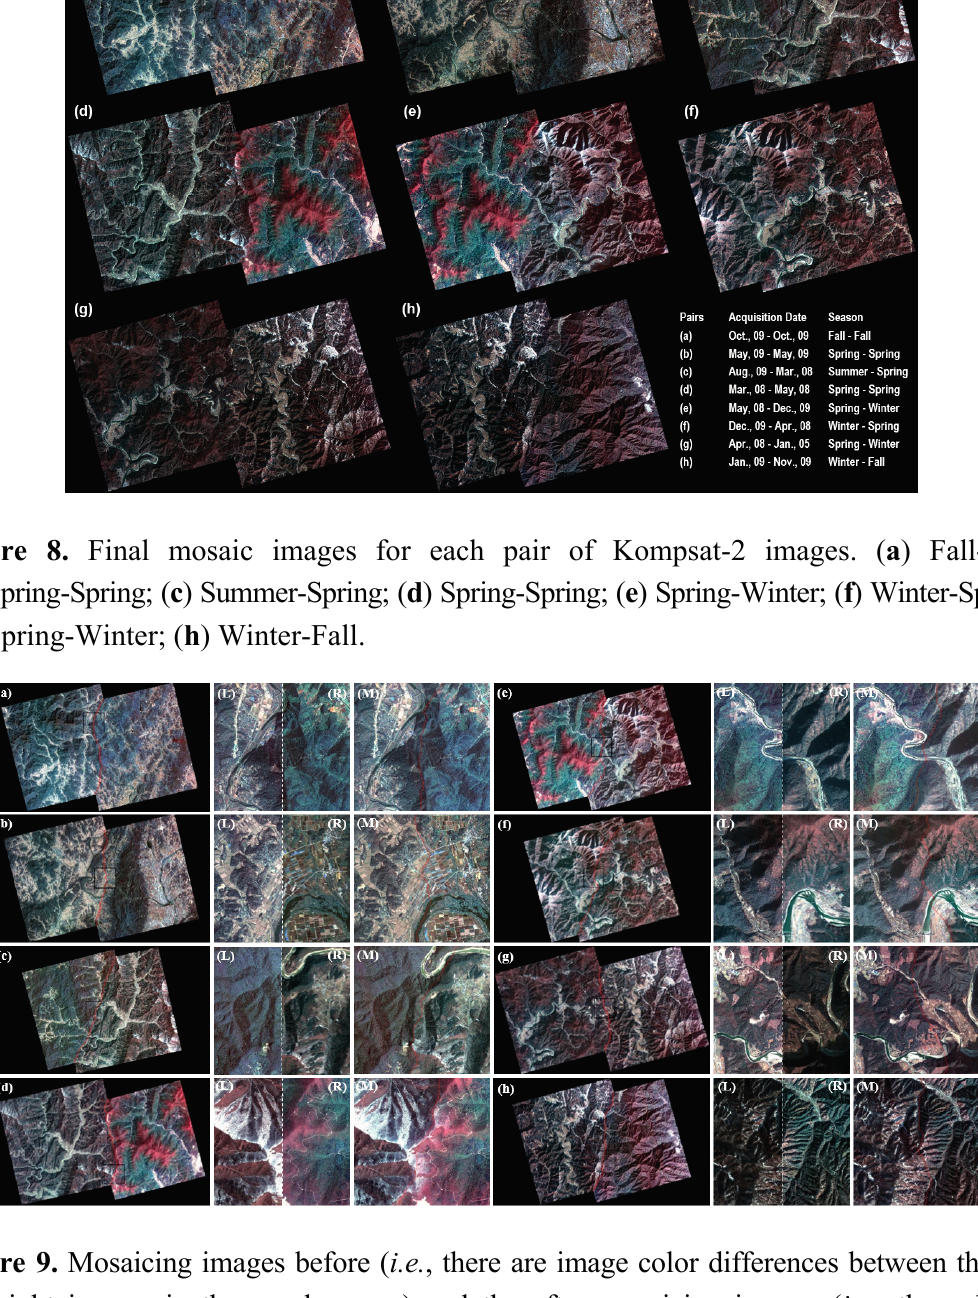
Figure 9. Mosaicing images before ( i.e. , there are image color differences between the left and right images in the overlap area) and the after mosaicing images ( i.e. , the color is adjusted over the entire area and the enlarged area). ( a ) Fall-Fall; ( b ) Spring-Spring; ( c ) Summer-Spring; ( d ) Spring-Spring; ( e ) Spring-Winter; ( f ) Winter-Spring; ( g ) Spring-Winter; ( h ) Winter-Fall; ( L ) Enlarged left area before mosaic; ( R ) Enlarged right area before mosaic; ( M ) Enlarged mosaic